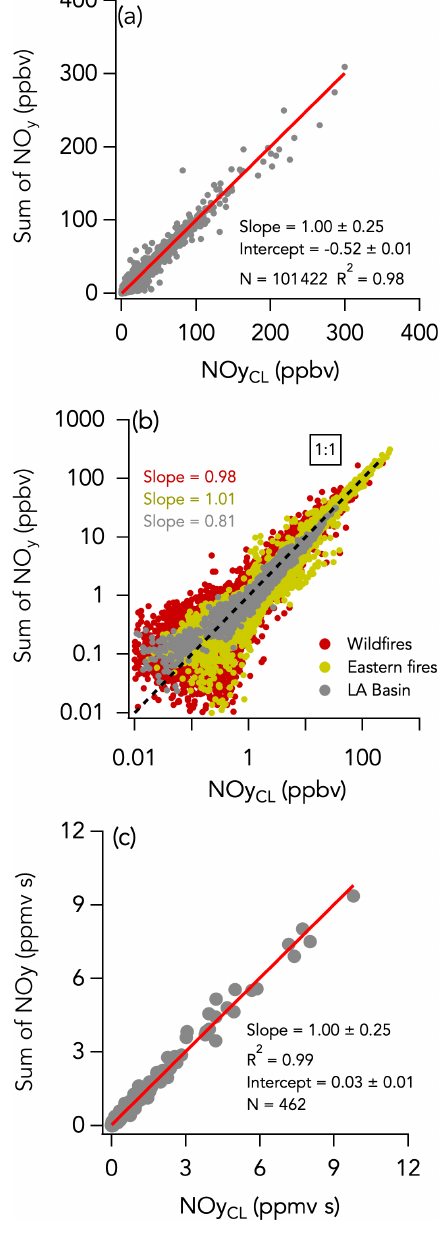
Figure 9. The same as Fig. 2 but comparing the sum of individually measured NO y species ( = NO x + HONO + HNO 3 + APNs + p NO 3 ) with the total NO y measurement by CL. Data from the entire campaign are presented in panels (a) and (b)